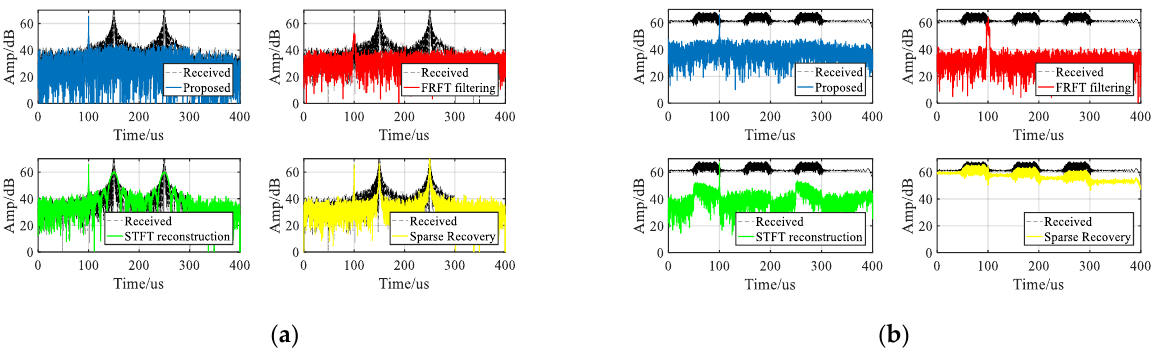
Figure 12. Comparison of the pulse compression range profile of the proposed method, FRFT filtering, STFT reconstruction and Sparse Recovery. ( a ) ISRJ; ( b ) SMSP jamming.